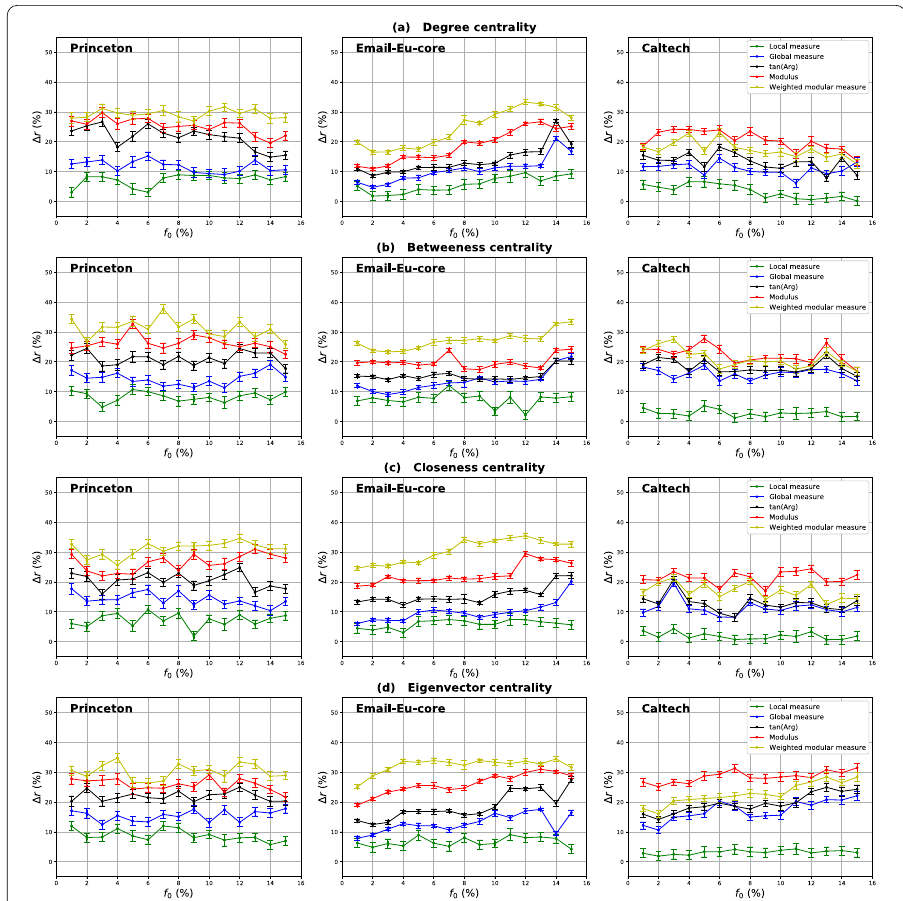
Figure 4 The relative difference of the outbreak size (cid:8) r as a function of the fraction of initial spreaders f 0 . The Degree ( a ), Betweenness ( b ), Closeness ( c ) and Eigenvector ( d ) centrality measures derived from the Modular centrality are compared to the standard counterpart designed for networks with no community structure. Real-world networks with medium community structure (Princeton, Email-Eu-core and Caltech) are used. The estimated values of their mixing coefficient is equal respectively to 0.354, 0.42 and